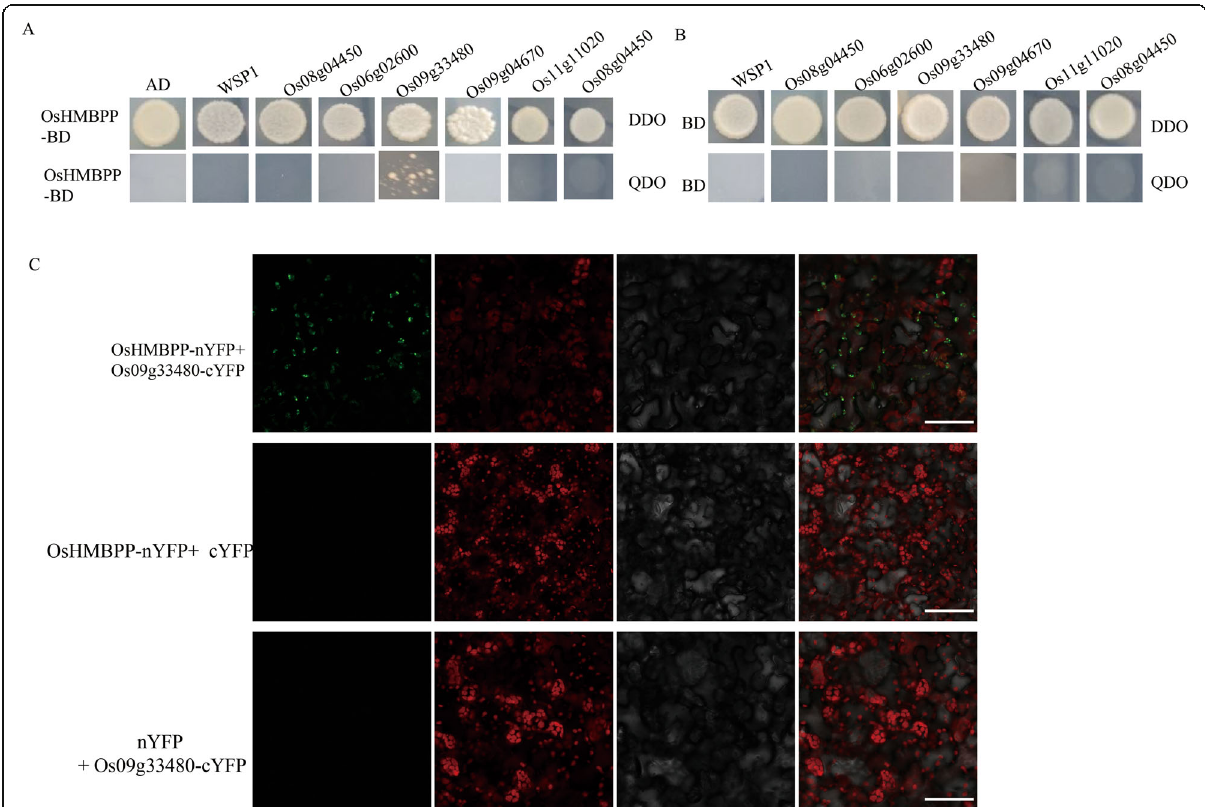
Fig. 9 The interaction assay between OsHMBPP and MORF families in rice. a - b OsHMBPP was fused to the pGBKT7 vector (OsHMBPP-BD). Seven MORFs were fused to the pGADT7 vector. DDO, control medium (SD – Leu/ − Trp); QDO, selective medium (SD – Leu/ − Trp/ − His/ − Ade). c Interaction between OsHMBPP and Os09g33480 in BiFC assays. Bars = 100 μ